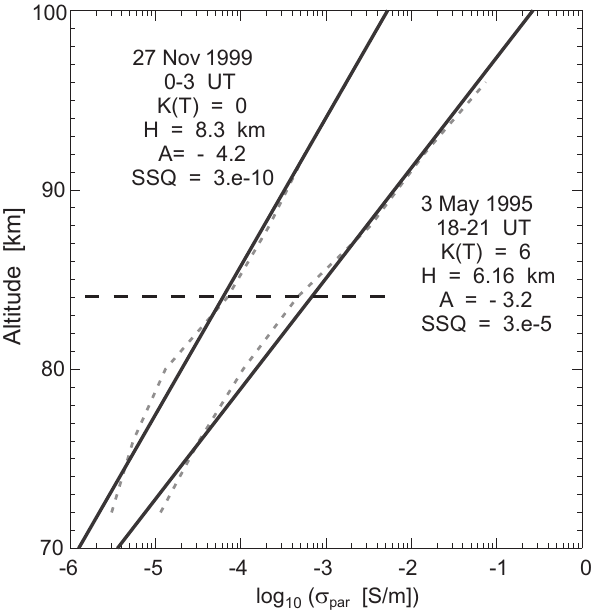
Fig. 3. Conductivity profiles calculated from the CP-6 median elec- tron density profiles (dashed lines) and the log-linear approxima- tion of these profiles by Eq. (4) for two different conditions. The respective model parameters H and A are indicated, together with the geomagnetic conditions and the goodness of the fit